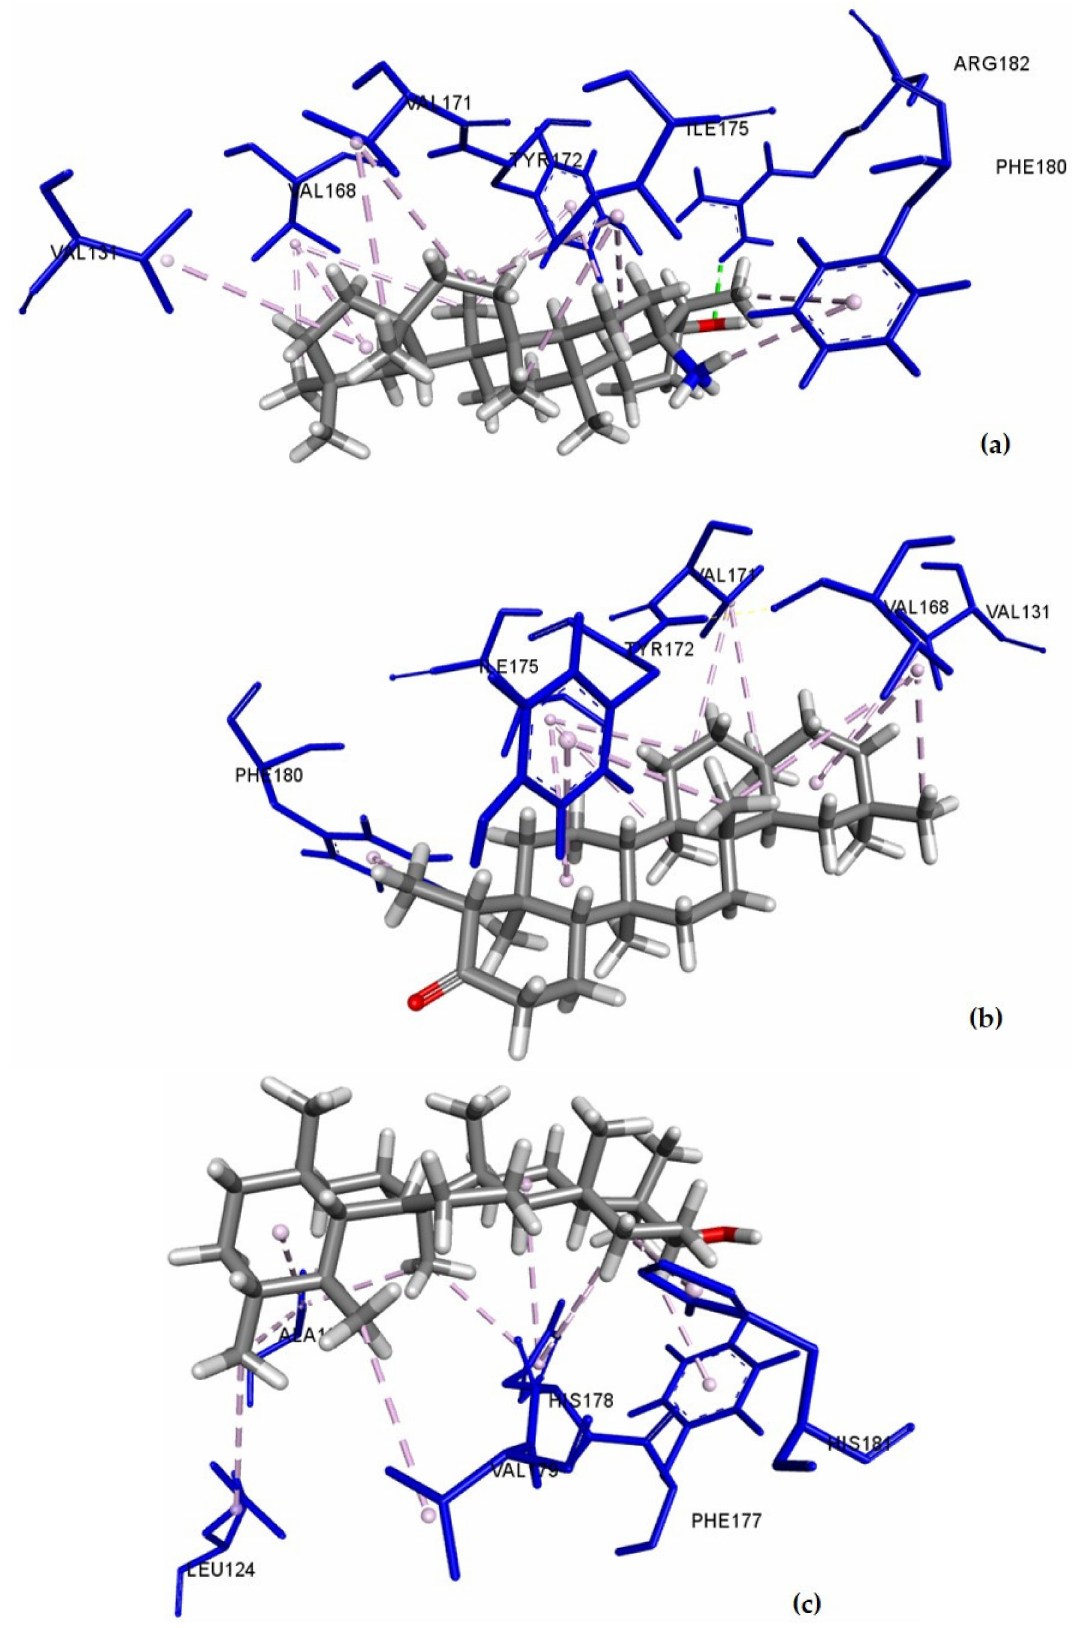
Figure 1. Docked pose of ( a ) epifriedelanol; ( b ) friedelin; ( c ) α -amyrin in the CB1 binding site showing molecular interactions—hydrogen and hydrophobic bonds as green and pink/purple dashed lines, respectively, generated by BIOVIA Discovery Studio